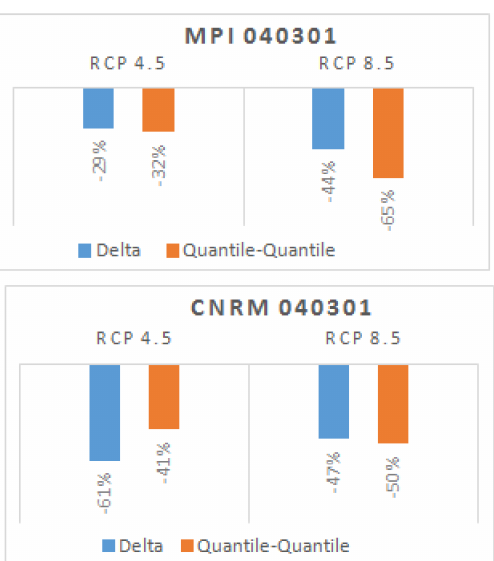
Figure 3. Variation des pluies futures (2075–2999) par rapport aux observations (1981–2005) après correction de biais par la méthode Delta et Q - Q (cas de la station Bousfer